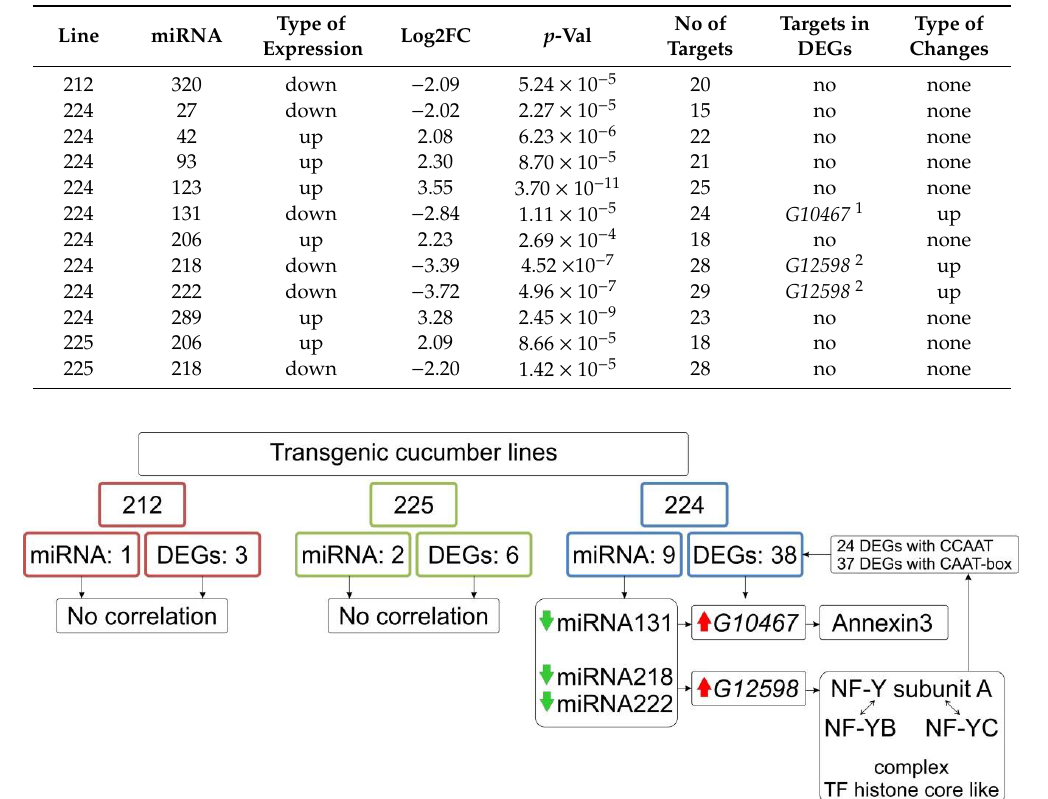
Figure 5 . Possible mechanism of epitranscriptome regulation in cucumber transgenic lines. Figure 5. Possible mechanism of epitranscriptome regulation in cucumber transgenic